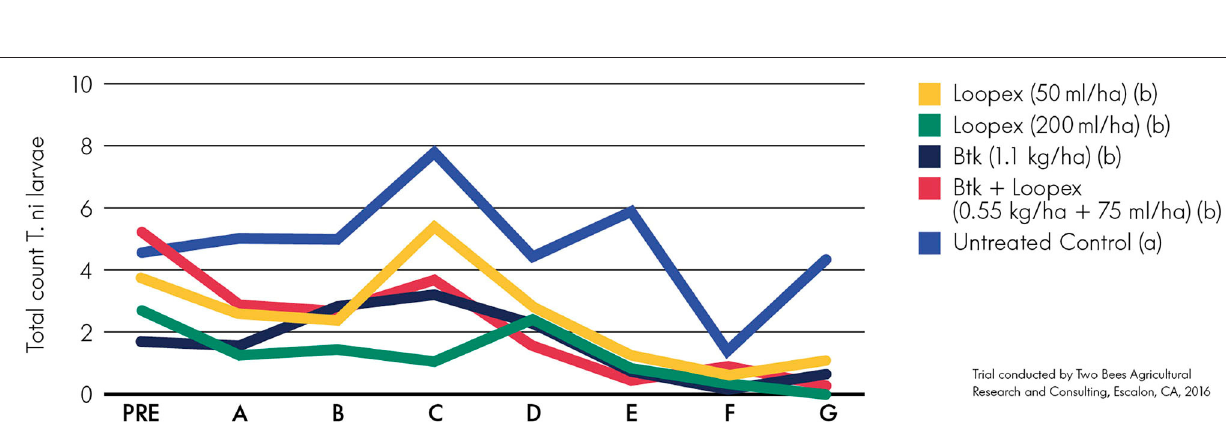
FIGURE 2 | Total mean number of T. ni larvae at the different assessment dates for the treatments (A–G are assessments 1 day after each treatment). Loopex was applied in two different application rates on broccoli alone or tankmixed with Btk. Data were analyzed using analysis of variance, followed by the LSD post-hoc test. Significance was determined by p < 0.05 and is shown by letters